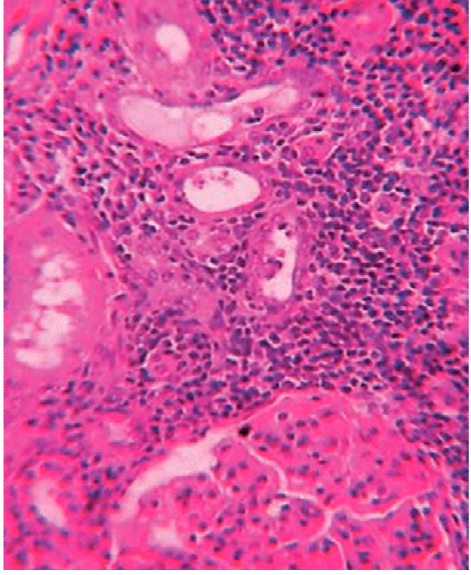
Figure 2. Tubular degeneration and necrosis of the kidney.